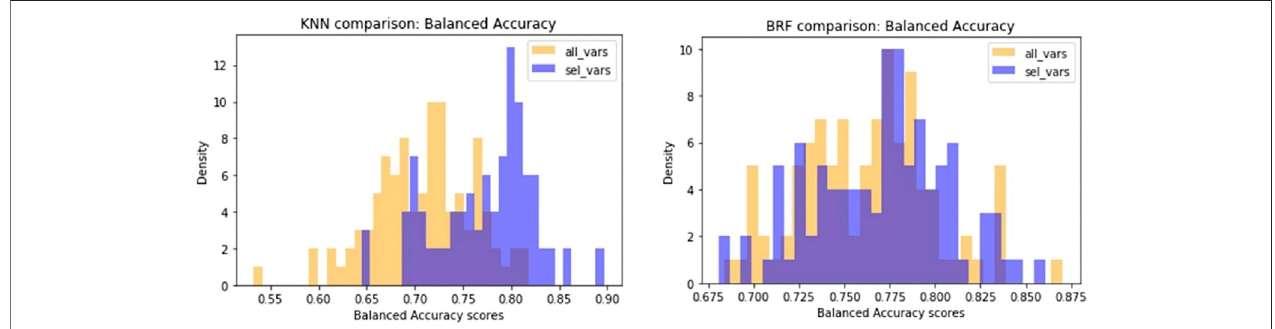
FIGURE 6 | Comparison of performance of models developed on random subsets of chemicals extracted from the ES. Violet bars refer to the distribution of BA of models based on the selected optimal features, while yellow bars are the distribution of BA of models based on the entire pool of descriptors.